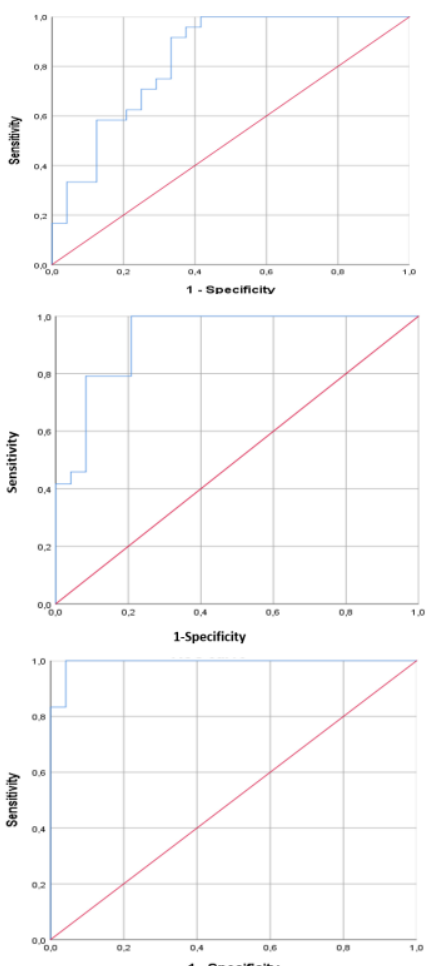
Figure 4. Two-dimensional PCA plot showing the discrimination of breathprints before smoking (blue circles) and 60 min after smoking (black stars). REGR = regression.